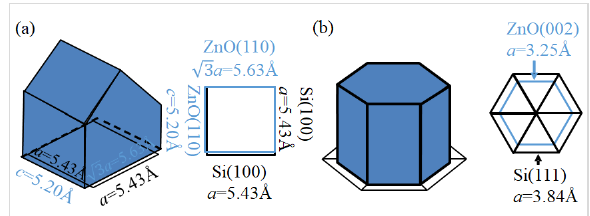
Figure 5: (a) The lattice mismatch between a ZnO(110) unit cell of 5.63 Å ( × lattice constant a ) by 5.20 Å (lattice constant c ) and a Si(100) cubic unit cell of 5.43 Å by 5.43 Å; (b) the lattice mismatch be- tween a hexagonal surface of a ZnO(002) unit cell with 3.25 Å sides and a hexagonal surface of six Si(111) triangular unit cells with 3.84 Å sides.